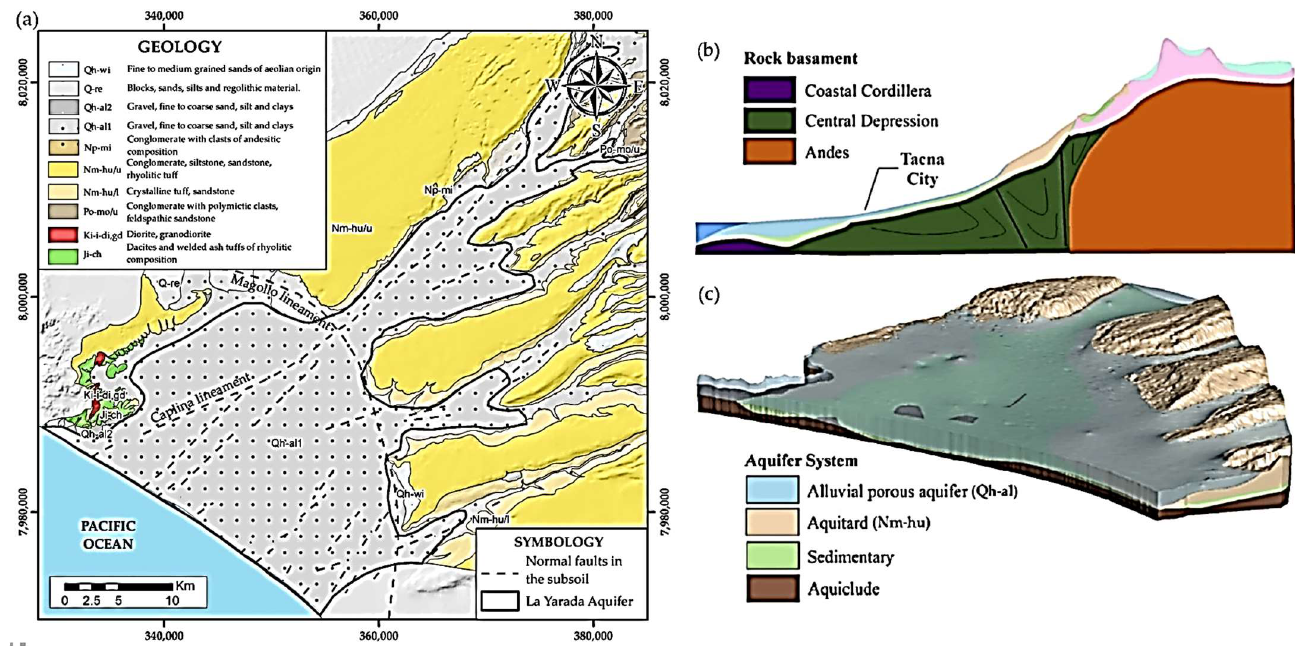
Figure 3. ( a ) Geological—structural map of La Yarada aquifer, ( b ) geomorfology Cross-section in Caplina Basin ( c ) 3D view of La Yarada aquifer [2].